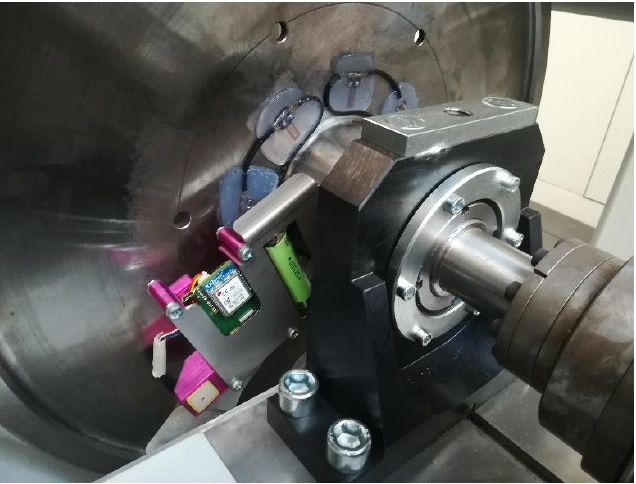
Figure 15. Strain gauge instrumented roller with wireless transmitter module.